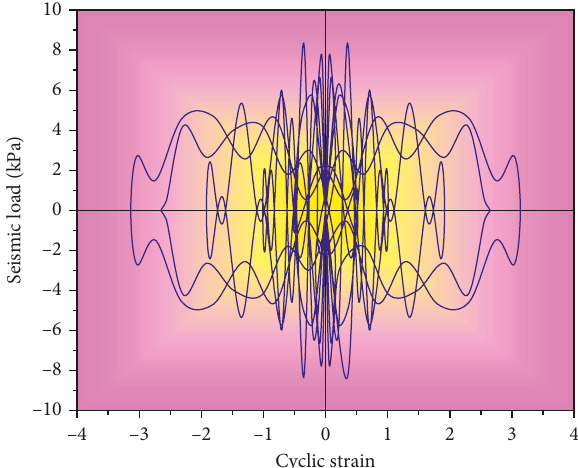
Figure 8: Seismic load (kPa) vs cyclic strain at the base of a concrete footing,